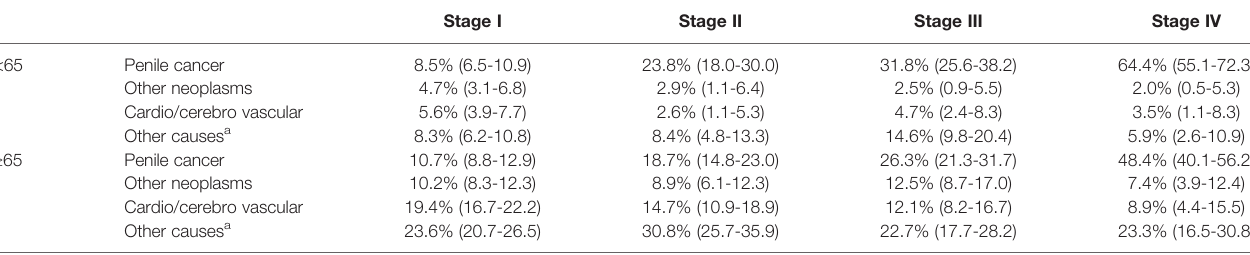
TABLE 2 | 5-year competing mortality strati fi ed by age at diagnosis and stage at